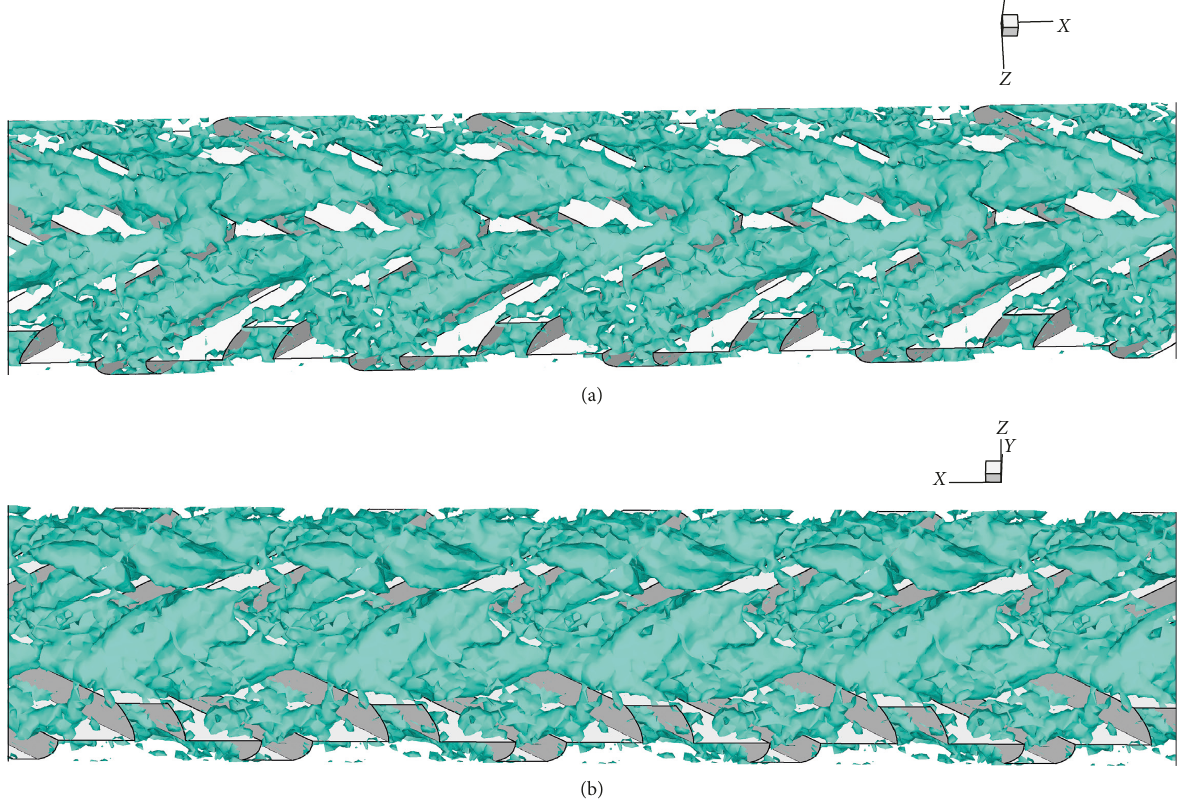
° and Re 6000 for (a) V-Downstream and (cid:28)